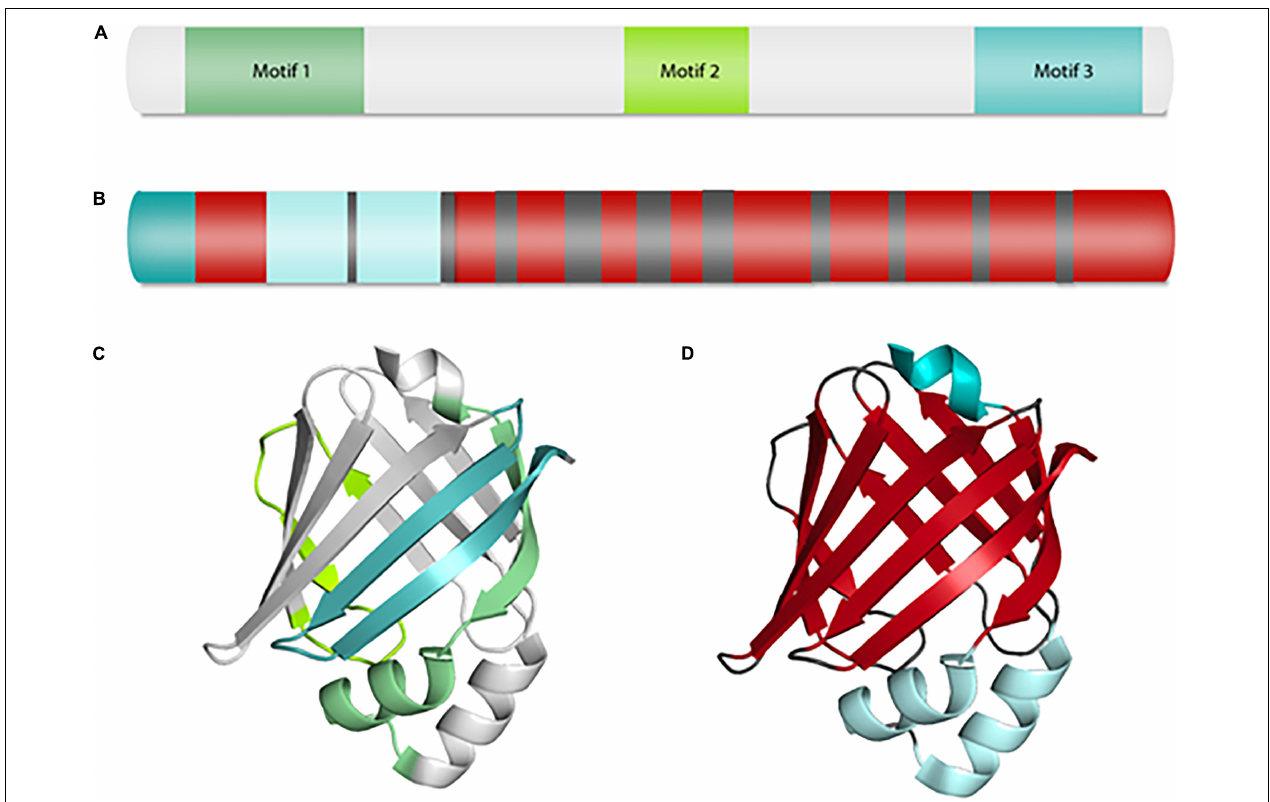
FIGURE 1 | Fatty acid binding protein structure. FABP7 primary protein and ribbon structures displaying structural components common among all FABPs. (A) Representative primary protein structure showing the three distinct fatty acid binding motifs found in all FABPs. (B) Primary protein structure depicting the distribution of alpha helices (light blue and teal) and beta sheets (red). (C) Ribbon structure of FABP7 depicting the three conserved motifs shown in (A) . (D) Ribbon structure of FABP7 highlighting the placement of the ten-stranded beta barrel (red) and N-terminal helix-turn-helix motif forming a “cap” domain (light blue) shown in (B) . This figure depicts FABP7 (PDB code: 6L9O) and was created using